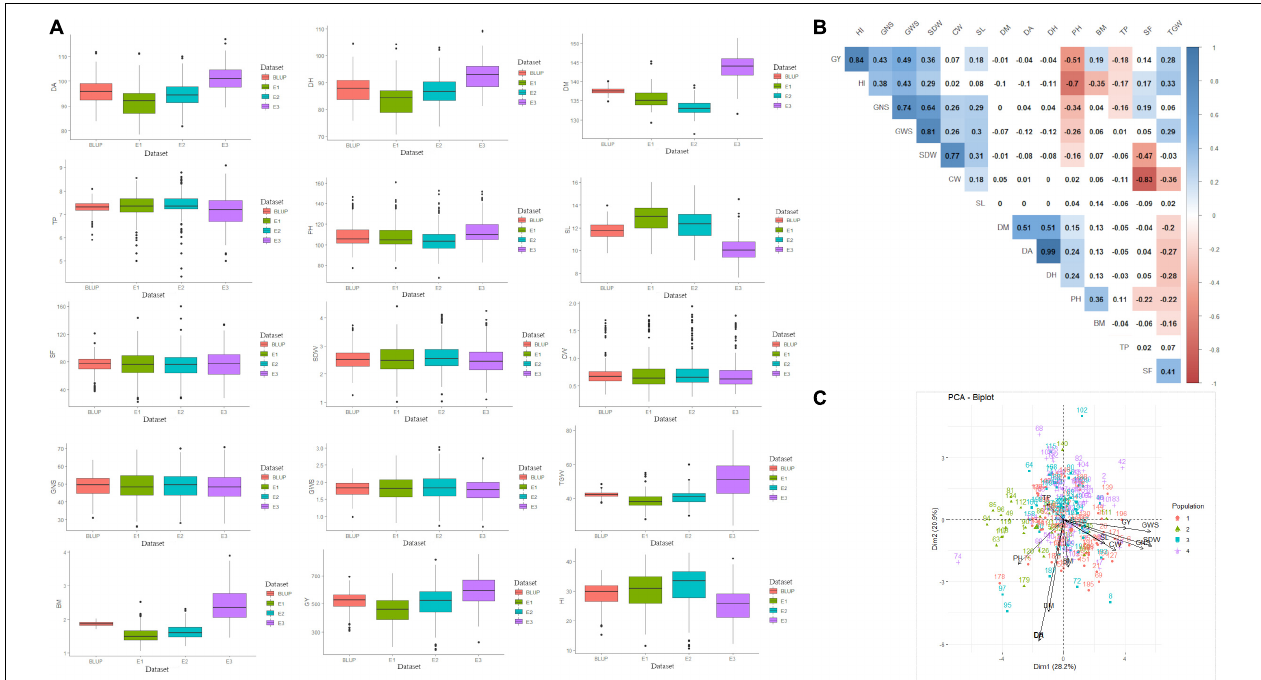
FIGURE 1 | (A) Summary of data observed for 15 agro-phenological traits, (B) correlation among studied traits, and (C) genotype-trait biplot summarizing the genetic variability. In figure, BLUP, Best Linear Unbiased Prediction; E1, the year 2016–2017; E2, the year 2017–2018; E3, the year 2018–2019; DH, days to heading; DA, days to anthesis; DM, days to maturity; PH, plant height; SF, spike fertility; CW, chaff weight; SDW, spike dry weight; SL, spike length; GNS, grain number per spike; GWS, grain weight per spike; TGW, thousand grains weight; GY, grain yield; TP, tiller per plant; HI, harvest index; BM,